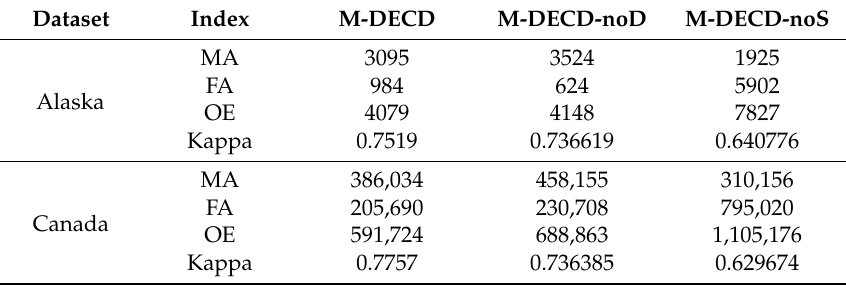
Figure 17. Results of the M-DECD series of methods with various combinations of image features. ( a ) CMs of the M-DECD. ( b ) CMs of the M-DECD-noD. ( c ) CMs of the M-DECD-noS. ( d ) Reference map. Yellow ovals refer to the false detection areas compared with the M-DECD, and the red ovals refer to the miss-detection areas compared with the M-DECD. Table 5. Accuracy of the results obtained with various combinations of image features.